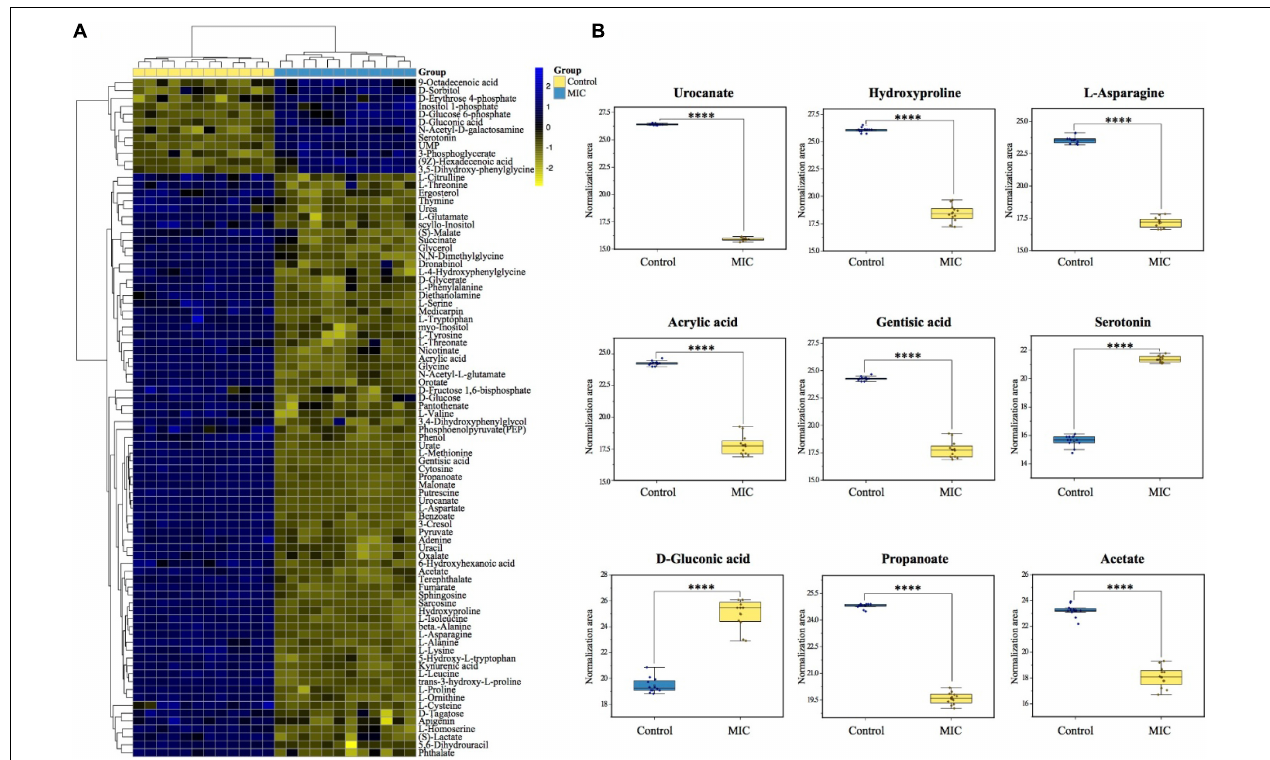
FIGURE 5 | Differential metabolite heat map and biomarker identification. (A) The heatmap was constructed based on the differential metabolites in MIC group and Control group ( n = 12). The color key indicated metabolite abundance (blue: upregulation; yellow: downregulation). Rows: metabolites; Columns: samples. Control and MIC group were colored yellow and cyan, respectively. (B) The boxplots of biomarkers to show the difference between MIC group and Control